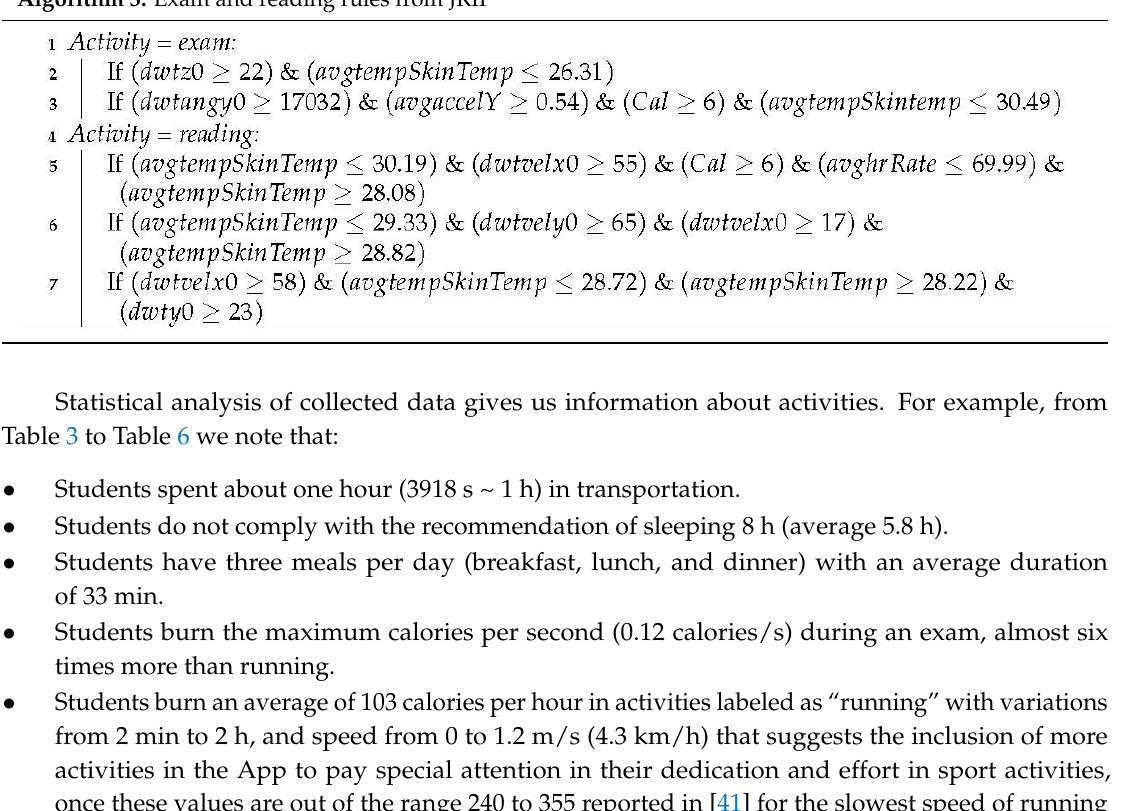
Figure 6. Confusion matrix for daily-activity classification with